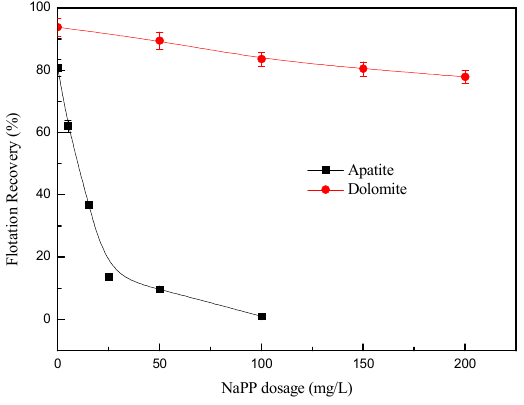
Figure 4. Effect of sodium pyrophosphate (NaPP) dosage on the flotation of apatite and dolomite. Table 1. Artificial mixed minerals flotation results (NaOL: 60 mg/L).